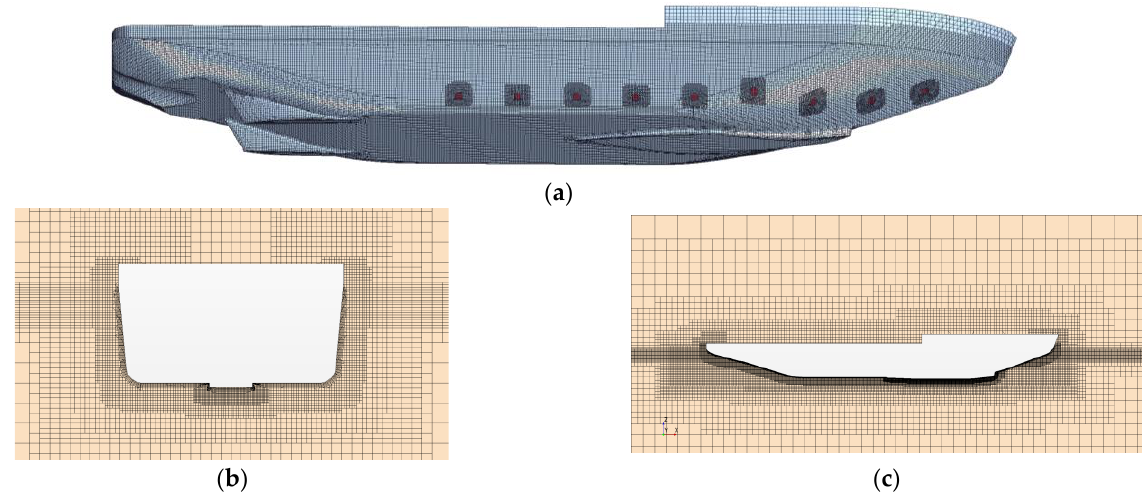
Figure 4. The meshing of the numerical model. ( a ) Ship hull mesh; ( b ) Front view of the flow domain; ( c ) Side view of the flow domain.